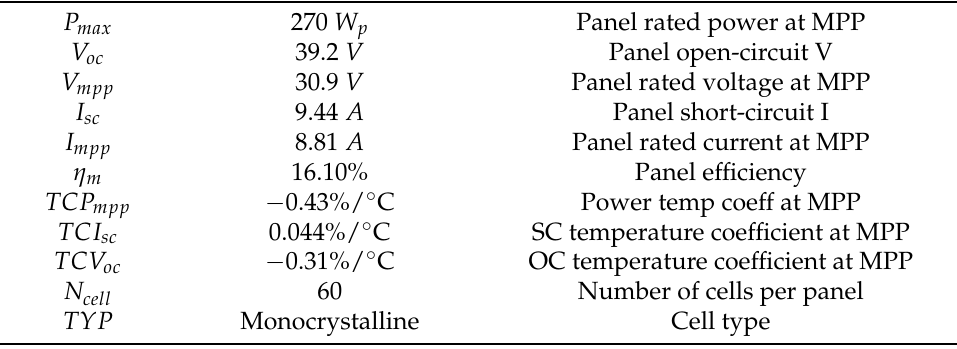
Table 1. SolarWorld Sunmodule Plus SW 270 Mono Black Panel